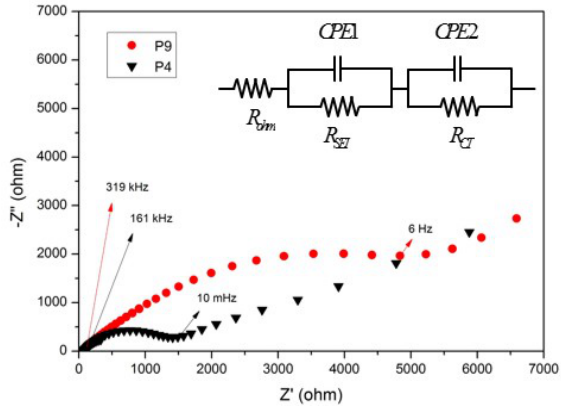
Figure 5. Electrochemical impedance spectra (EIS) patterns of P4 and P9 and equivalent circuit (inset). The depressed semicircles in the high- and low-frequency regions are related to the formation of an active material surface layer and the intercalation / deintercalation of lithium ions into / from the electrodes. An equivalent circuit was used to fit the spectra and is shown in the inset of Figure 5. The parameter R SEI and constant phase element of the solid electrolyte interface (SEI) film ( C PE1 ) correspond to the surface layer resistance and capacitance, respectively, whereas R ct and the constant phase element of the electrode / electrolyte interface ( C PE2 ) correspond to the lithium ion intercalation / deintercalation process and interfacial capacitance, respectively [35]. The calculated R ct for P4 and P9 are 1.8 and 9.9 kΩ, respectively. The lowest capacity of P9 is attributed to this large